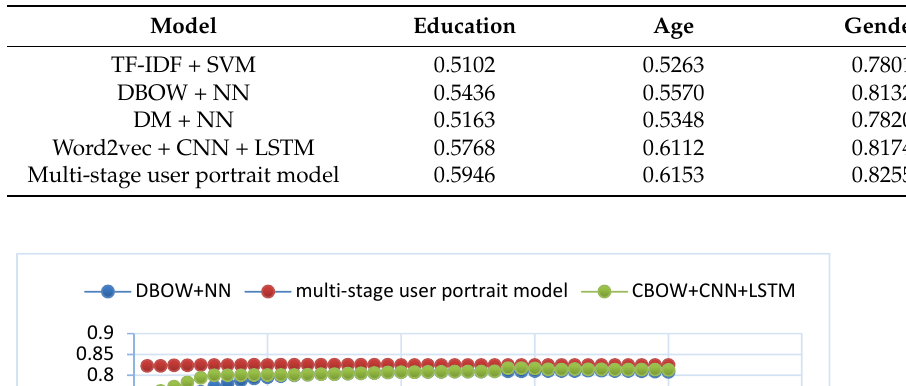
Table 6. Comparison of the prediction accuracy of the models.